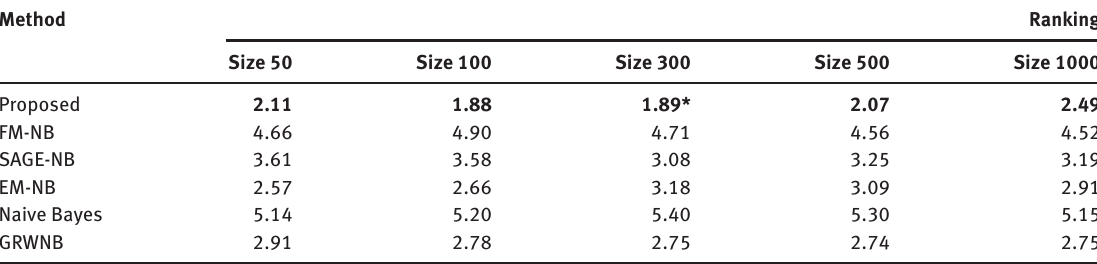
Table 3: Rankings of the Proposed Method and All Baselines for the Five Experimental Settings (Training Data Size in {50, 100, 300, 500, 1000}) Over All Corpora and All Binary Classifications Tasks. The CD Values for the Post Hoc Bonferroni-Dunn Test are 0.94 ( p < 0.05) and 0.85 ( p < 0.10). Bold Font Marks Highest Ranking. Asterisk Marks the Statistical Significance at p < 0.10 (for Details, see Text).